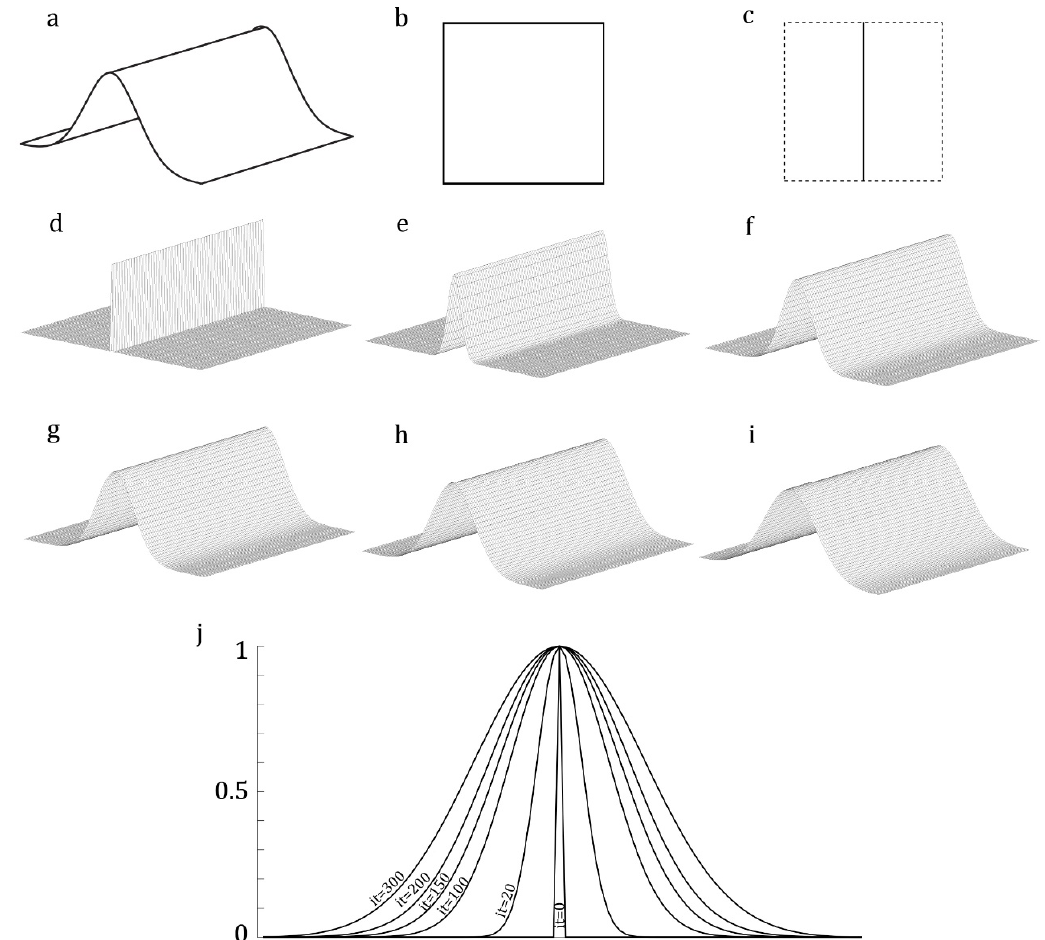
Figure 2. Modeling of an out-of-plane domain. ( a ) An out-of-plane domain. ( b ) A top view image of the domain. The image is used by the BA to detect the domain. ( c ) The secondary image contains a black line that represents the maximum height. The regions with zero height are colored in white. ( d ) A developed model based on the input images. ( e – i ) Smoothing the height of the meshed model using the iterative algorithm. ( j ) Changes in the corrugation pattern in different iterations.